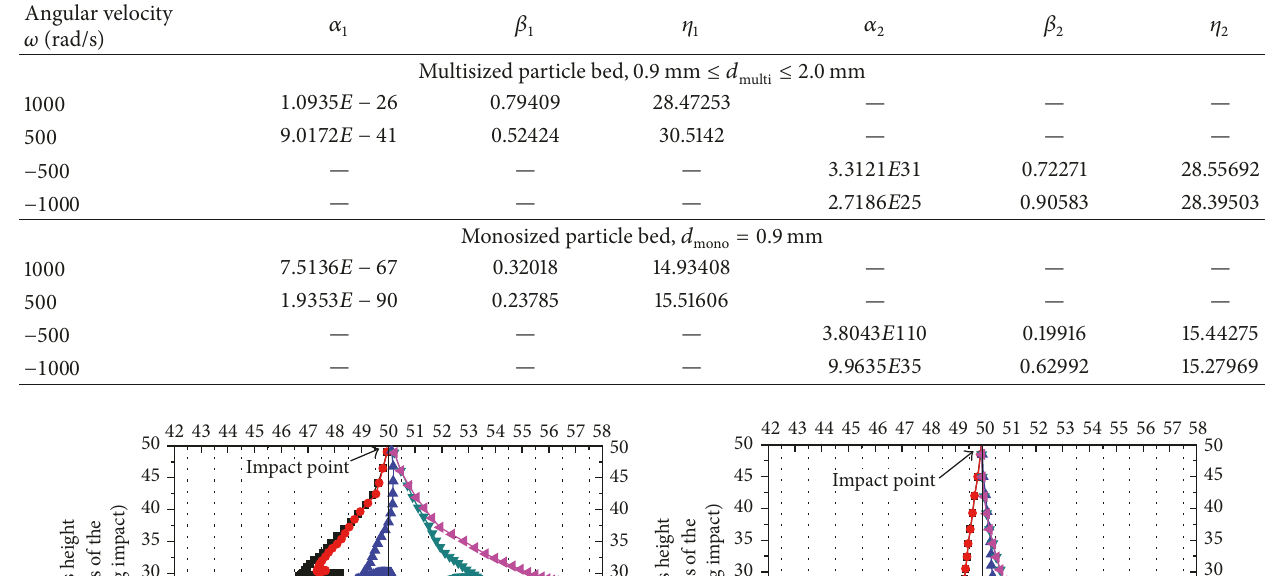
Table 3: The values of the constants: 𝛼 1 , 𝛽 1 , 𝜂 1 , 𝛼 2 , 𝛽 2 , and 𝜂 2 .